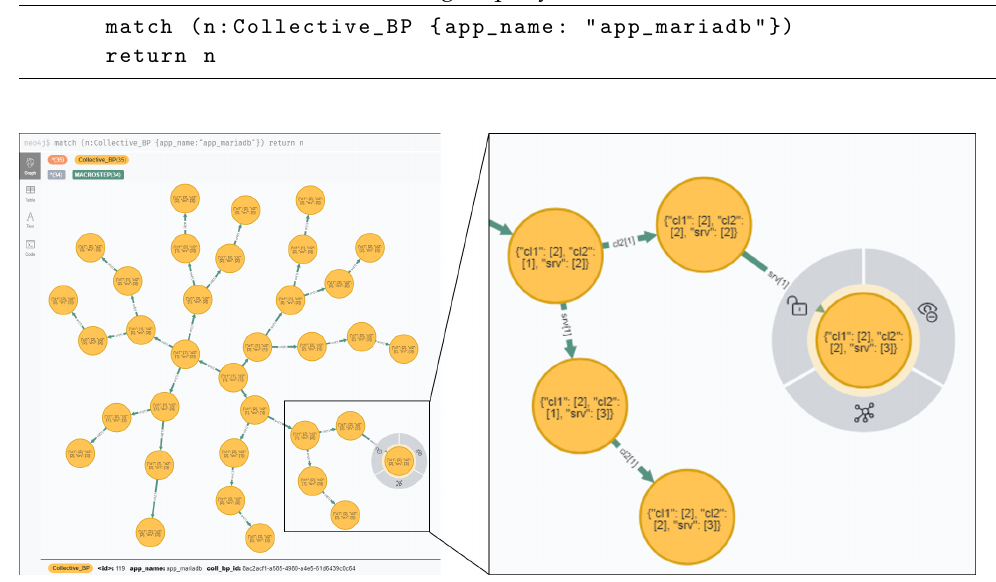
Figure 6. An execution tree and its subtree (right side) represented in